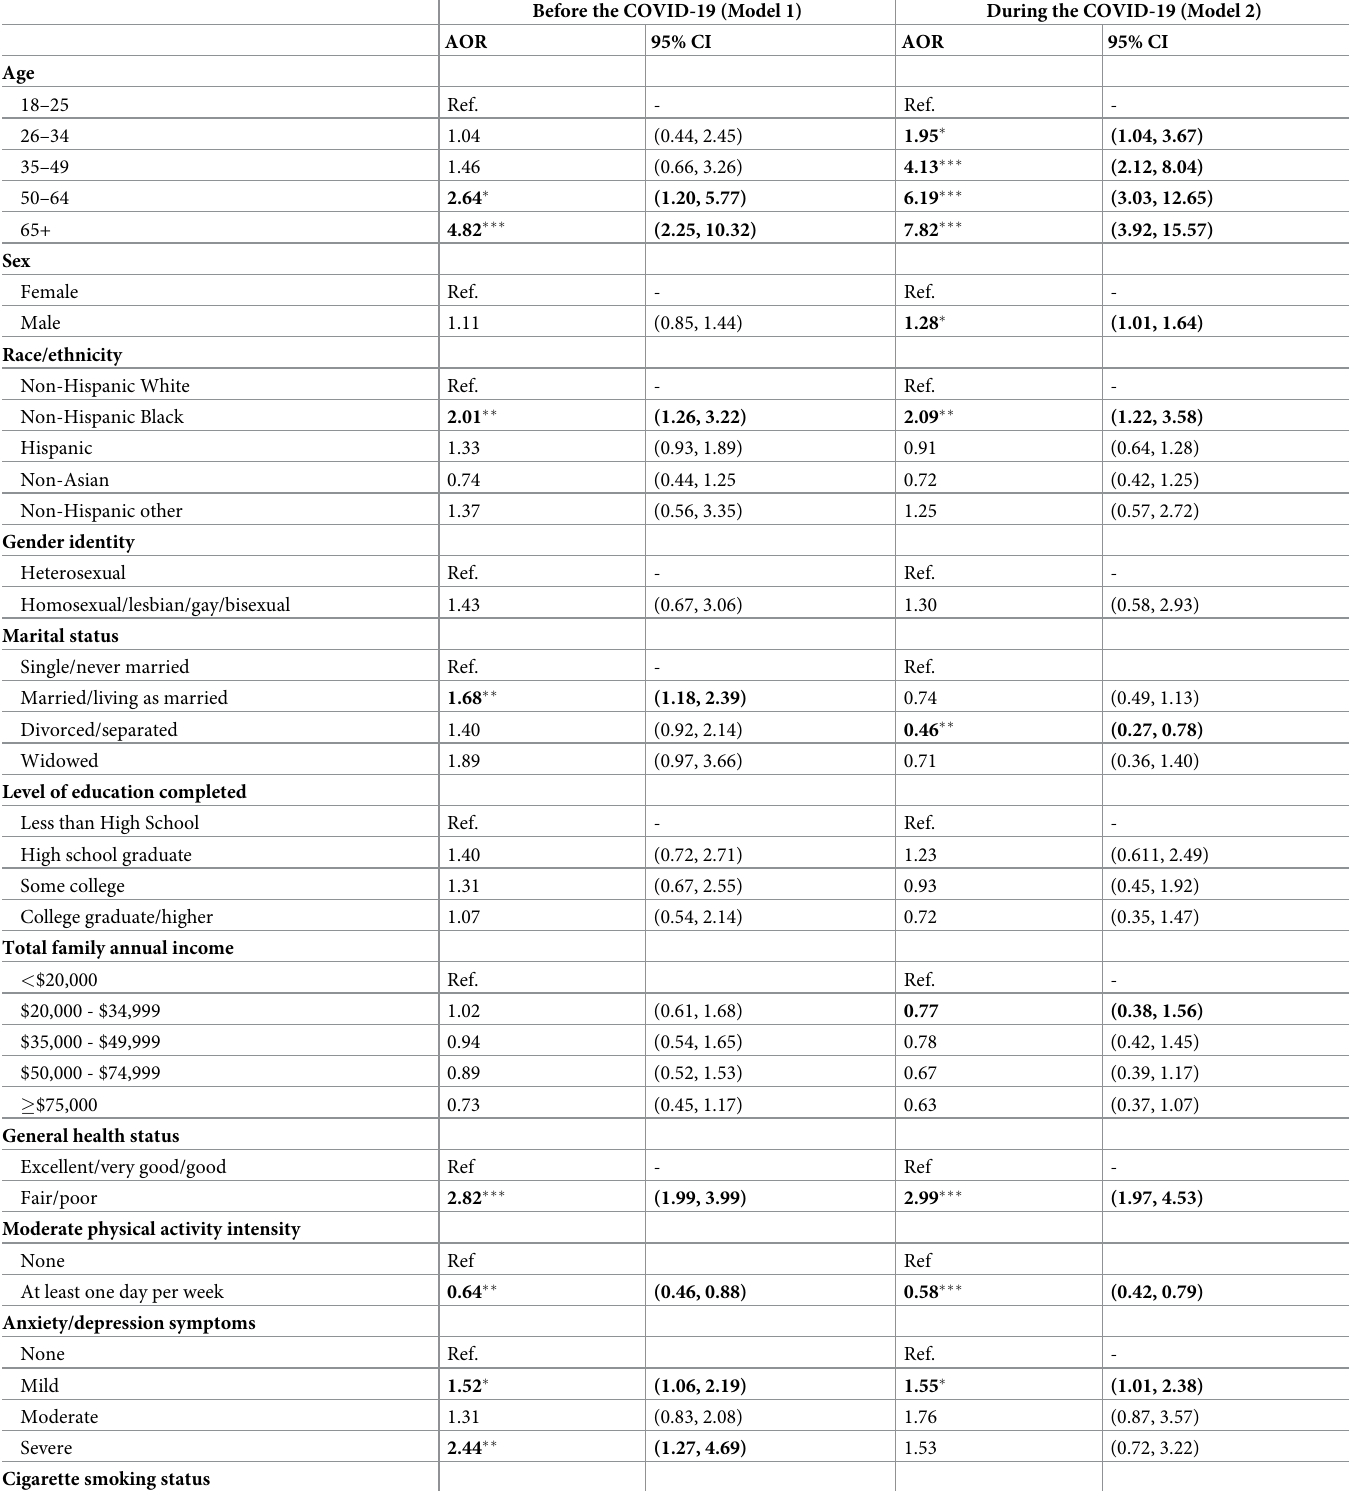
Table 2. The odds of metabolic conditions among U.S. adults before and during the COVID-19 pandemic (N =